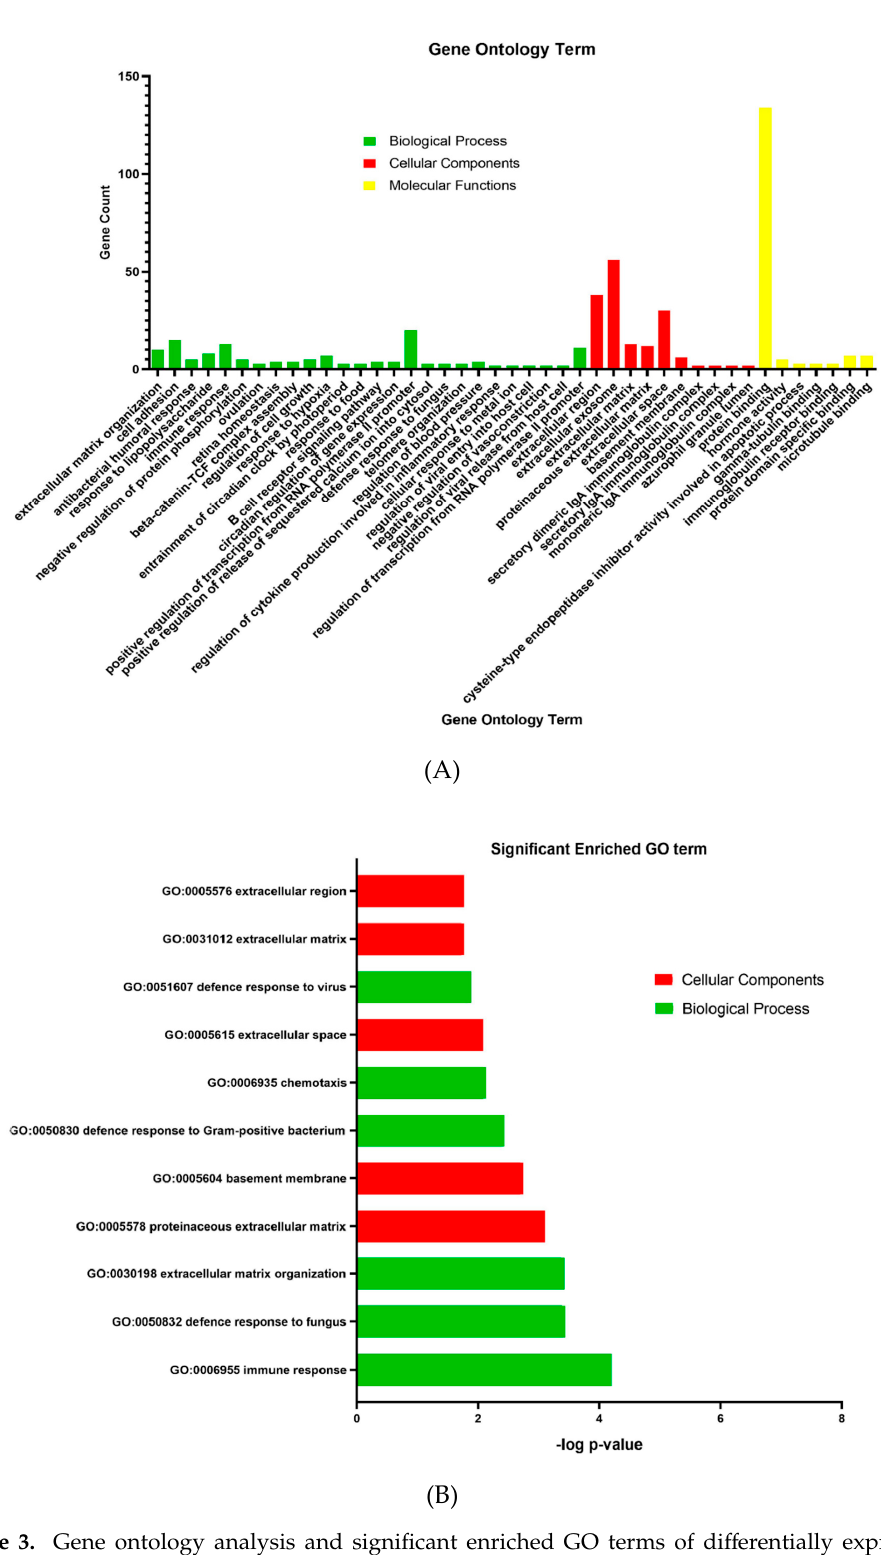
Figure 3. Gene ontology analysis and significant enriched GO terms of di ff erentially expressed genes in placenta tissue of patients with preeclampsia. ( A ) GO analysis classification of upregulated and downregulated di ff erentially expressed genes into three groups (i.e., biological process, cellular components, and molecular function). ( B ) Significantly enriched GO terms of upregulated and downregulated di ff erentially expressed genes in patients with preeclampsia based on their functions (11